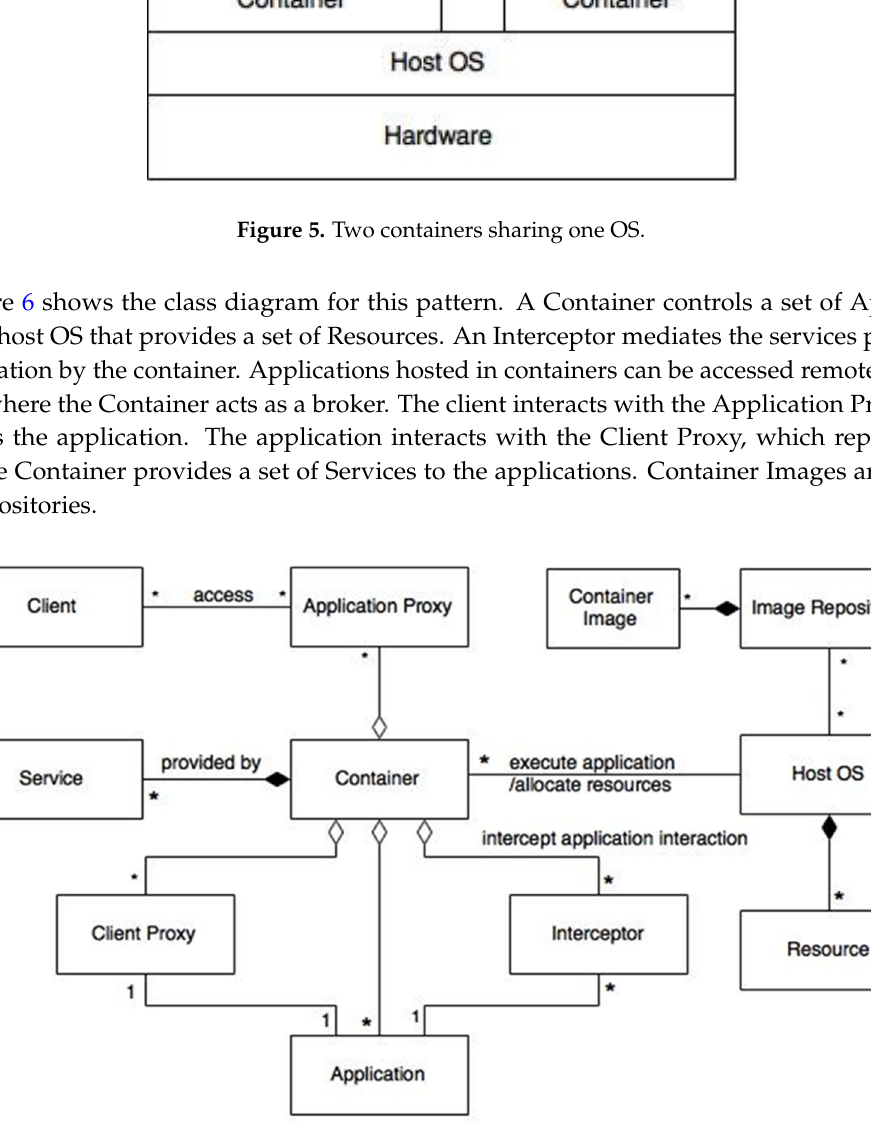
Figure 6. Class diagram of the container pattern.